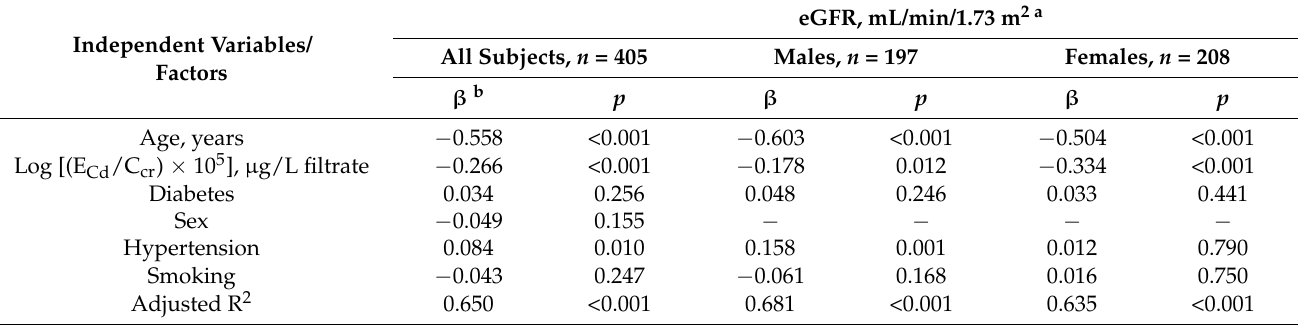
Table 3. Multiple regression analyses to determine strength of association of eGFR with log[(E Cd /Ccr × 10 5 ) and other independent